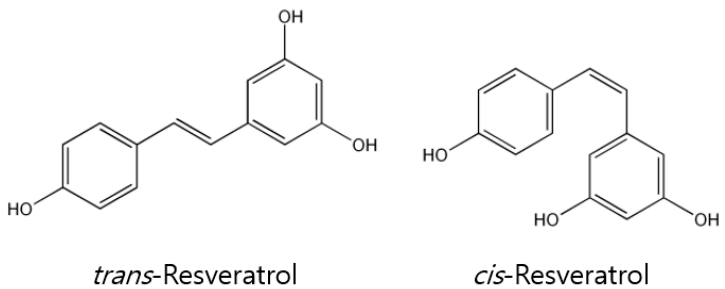
Figure 1. The chemical structure of two geometric isomers of resveratrol.